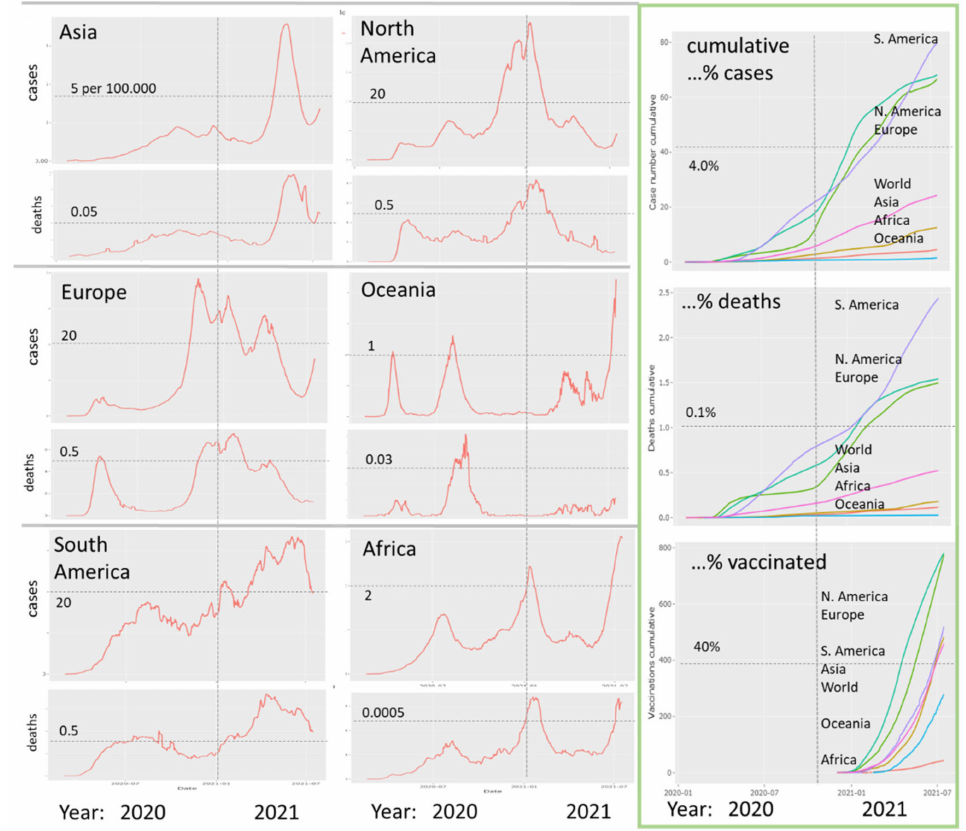
Figure A2. COVID-19 incidences and deaths across the world: number of cases (incidence) and number of deaths (both numbers are counted per day and per 100,000 of population) in different regions of the world were plotted as a function of date since January 2020. One sees the different waves of the pandemic arising, e.g., in Europe in spring 2020 and from autumn 2020 to summer 2021. Cumulative incidences, deaths and percentages of vaccinated people (first shot) across the world are shown in the right (green frame). Graphs were generated using the COVID-19 viewer (https: //www.izbi.uni-leipzig.de/current-projects/covid19-viewer/, downloaded on 17 July 2021) [28]. Note: Number of cases before summer 2020 (1st. wave) is biased towards small values because of the relatively small number of tests. Number of deaths roughly followed the number of cases in Asia, South America, Oceania and Africa. In Europe and North America, the deaths in the last (summer) wave 2021 are relatively small presumably because of non-pharmaceutical interventions (NPIs), medical measures and also progressing vaccination. South America is leading the number of cases and of deaths at present. North America and Europe are leading the vaccination (first